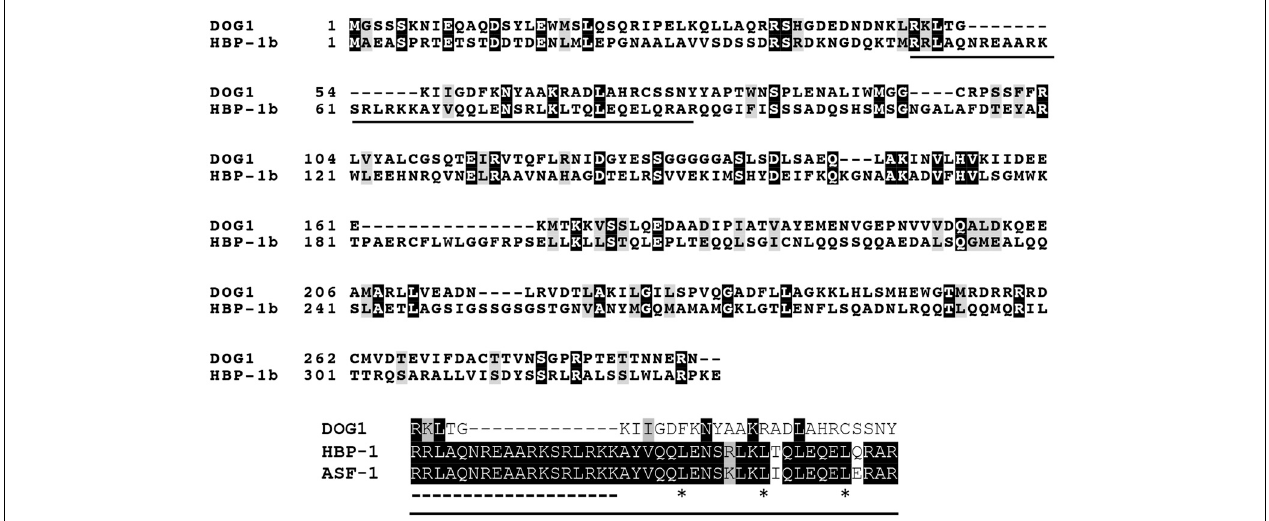
FIGURE 1 | Alignment of Arabidopsis DOG1 , wheat HBP-1b and tobacco ASF-1. Arabidopsis DOG1 ( DELAY OF GERMINATION1 ) encodes an unknown protein, which shows some similarity to the wheat HBP-1b (Histone gene Binding Protein-1b), a leucine zipper class transcription factor (Bentsink et al., 2006). However, the DOG1 protein does not show high identity to the leucine zipper domain in the HBP-1b (solid underline in the top